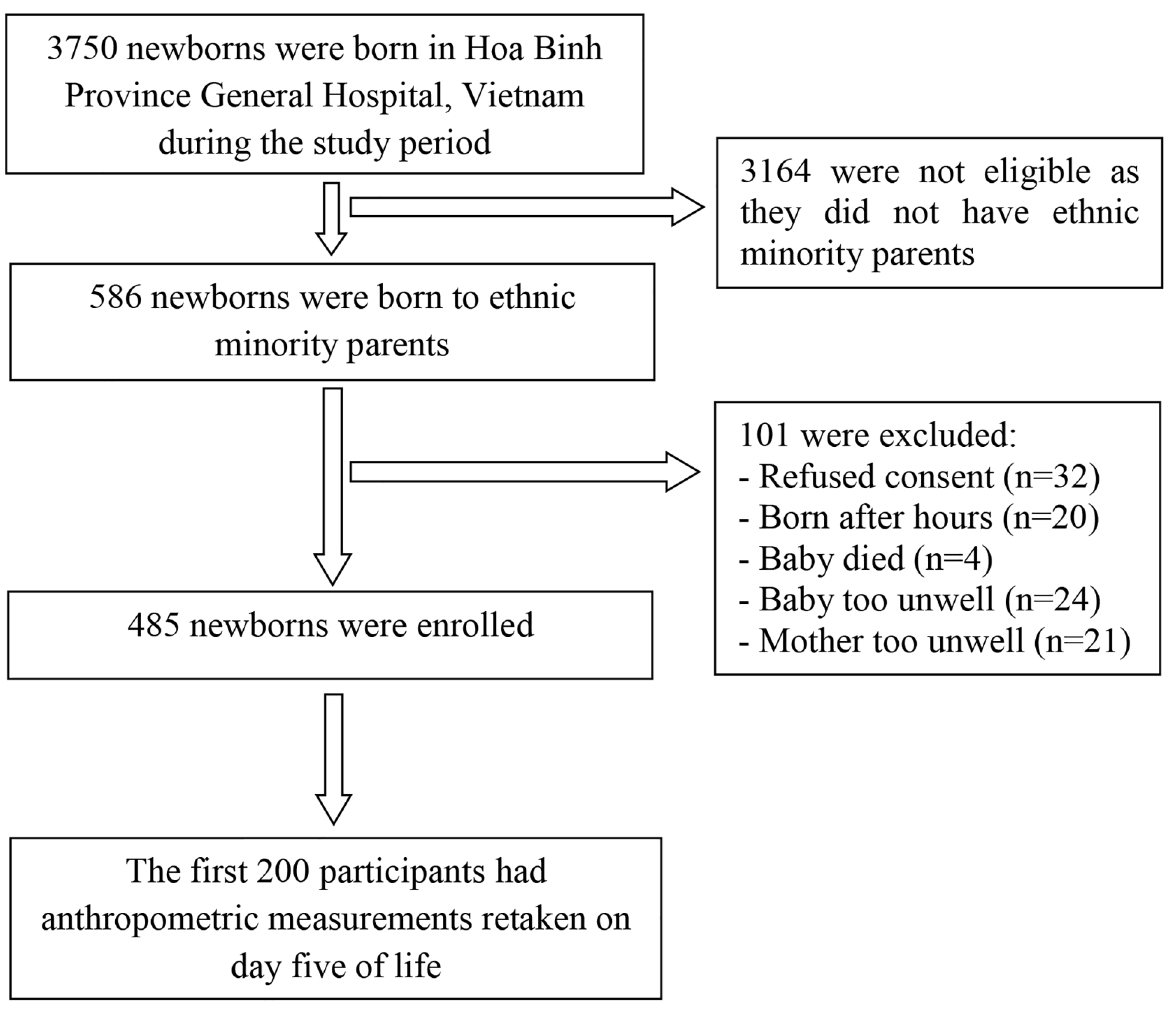
Fig 1. Flowchart of recruitment of study participants at Hoa Binh Province General Hospital, Vietnam. Table 2 presents the optimal cut-points for each anthropometric measure as a predictor of each outcome, along with the sensitivity, specificity, PPV and NPV based on the given cut- point. The optimal cut-points identified for each diagnostic tool were similar across the three outcomes: for foot length, these cut points were between 7.3 cm and 7.4 cm; for chest circum- ference, between 30.0 cm and 30.4 cm; for MUAC, between 8.7 cm and 9.0 cm. The sensitivity and specificity at the optimal cut-points were similar for chest circumference and MUAC as predictors of each outcome (p for difference > 0.05 in all cases), and were typi- cally marginally higher than for foot length, with the strongest statistical evidence for such dif- ferences when LBW was the outcome (p < 0.05 for all differences when LBW was the outcome). Since the optimal cut-points were chosen to have sensitivity of at least 0.80, by definition the point estimates of the sensitivity were always (cid:3) 0.80, but the 95%CIs sometimes included values below 0.80 (this occurred for foot length and MUAC as predictors of prematurity, and foot length as a predictor of LBW). Point estimates of the specificity at each optimal cut-point were